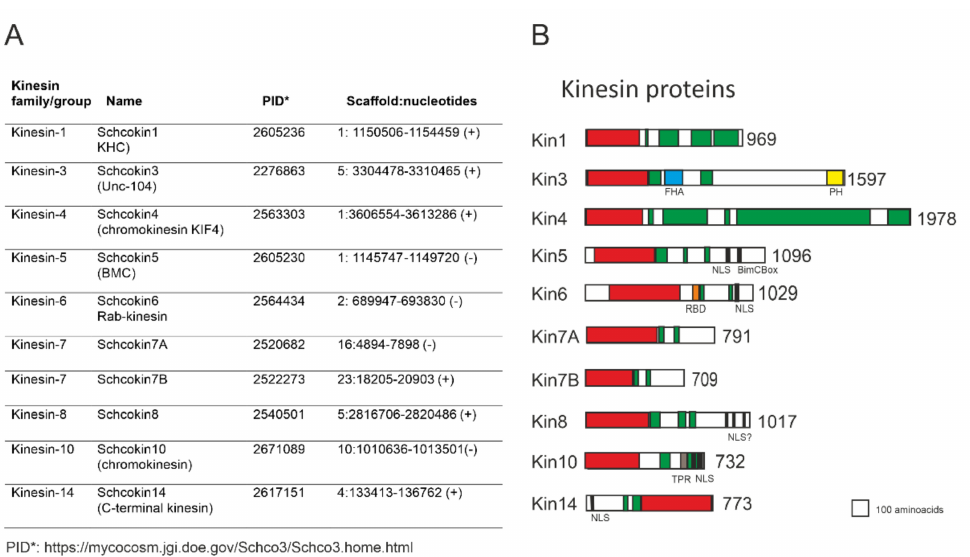
Figure 1. Schizophyllum commune kinesin genes and proteins. ( A ) The location of the kinesin genes in the S. commune genome. ( B ) A schematic drawing of kinesins with various domains and amino acid counts. The motor domain is red, the FHA forkhead-associated domain is blue, the PH plekstrin homology domain is yellow, the RBD Rab6-biding domain is orange, the TPR tetratricopeptide repeat domain is dark yellow (InterProScan and NCBIBlast), the coiled-coils are green (InterProteinScan) and the NLS nuclear localization signal bar is black (NLStradamus/localization signal, NLS Mapper).